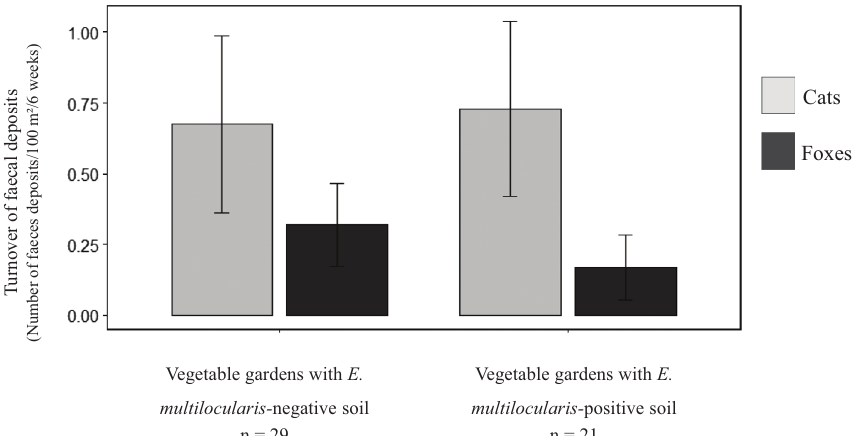
Figure 4. Average turnover of fox and cat faecal deposits in rural vegetable gardens ( N = 50) sampled in north-eastern France, with soil testing negative and positive for E. multilocularis eggs DNA. Line segments represent the standard